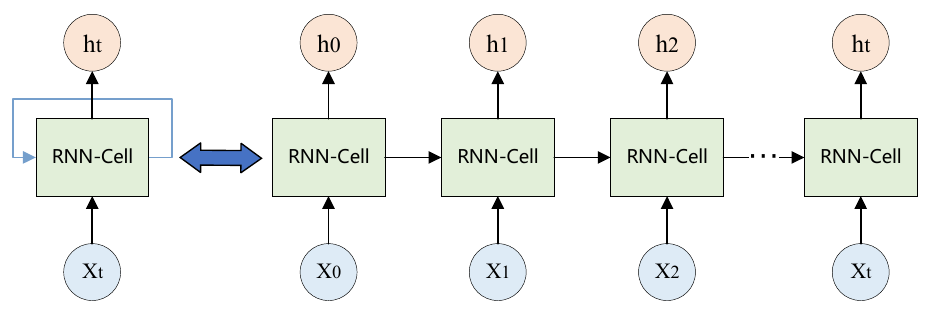
Figure 6. Chain structure of an RNN.